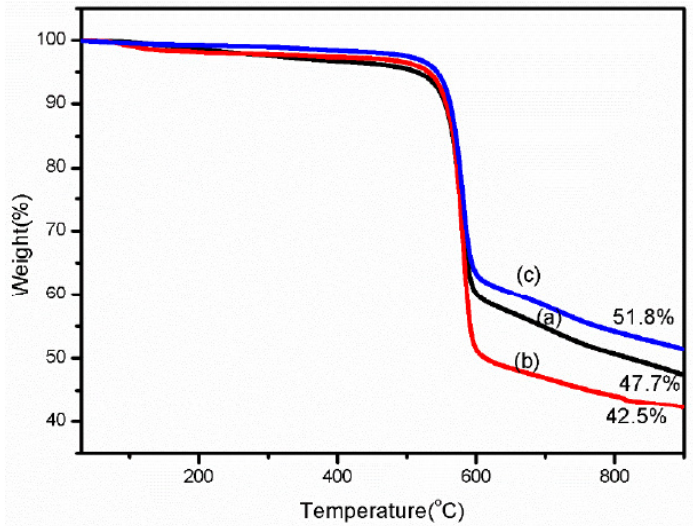
Figure 10. Thermogravimetric analysis (TGA) curves of Kevlar 49 fibers before and after scCO 2 treatment SAXS Patterns for Kevlar 49 fibers treated in different conditions (a)—as received, (b) treated in scCO 2 without tension, (c) treated in scCO 2 under tensions of 0.6 cN/dtex.